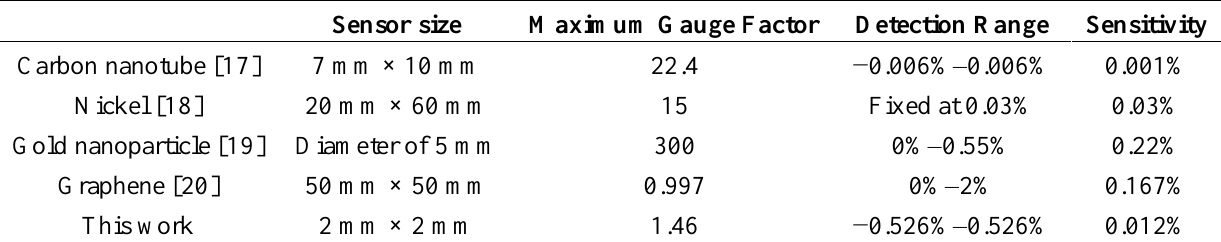
Table 1. Specification comparison between different resistive strain